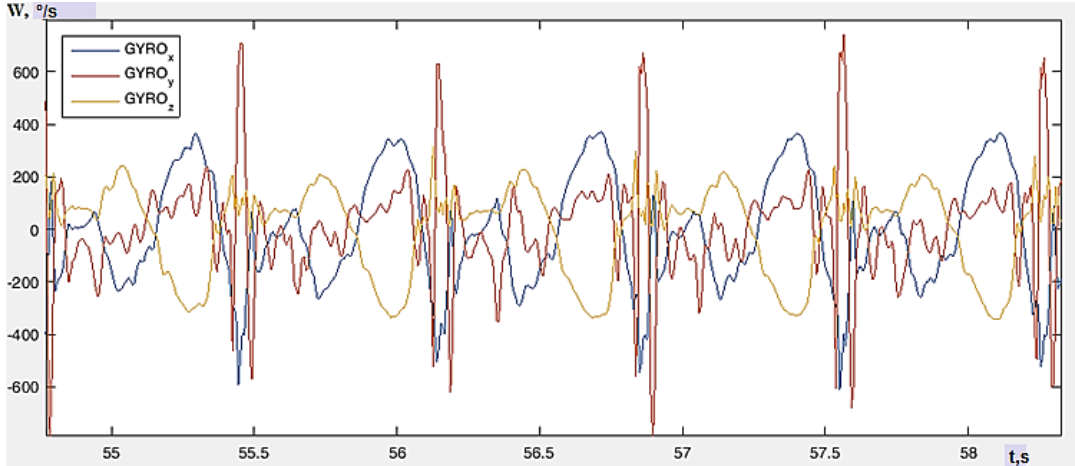
Figure 3 . Example of gyroscope signals across the three axes of coordinates during the study of running